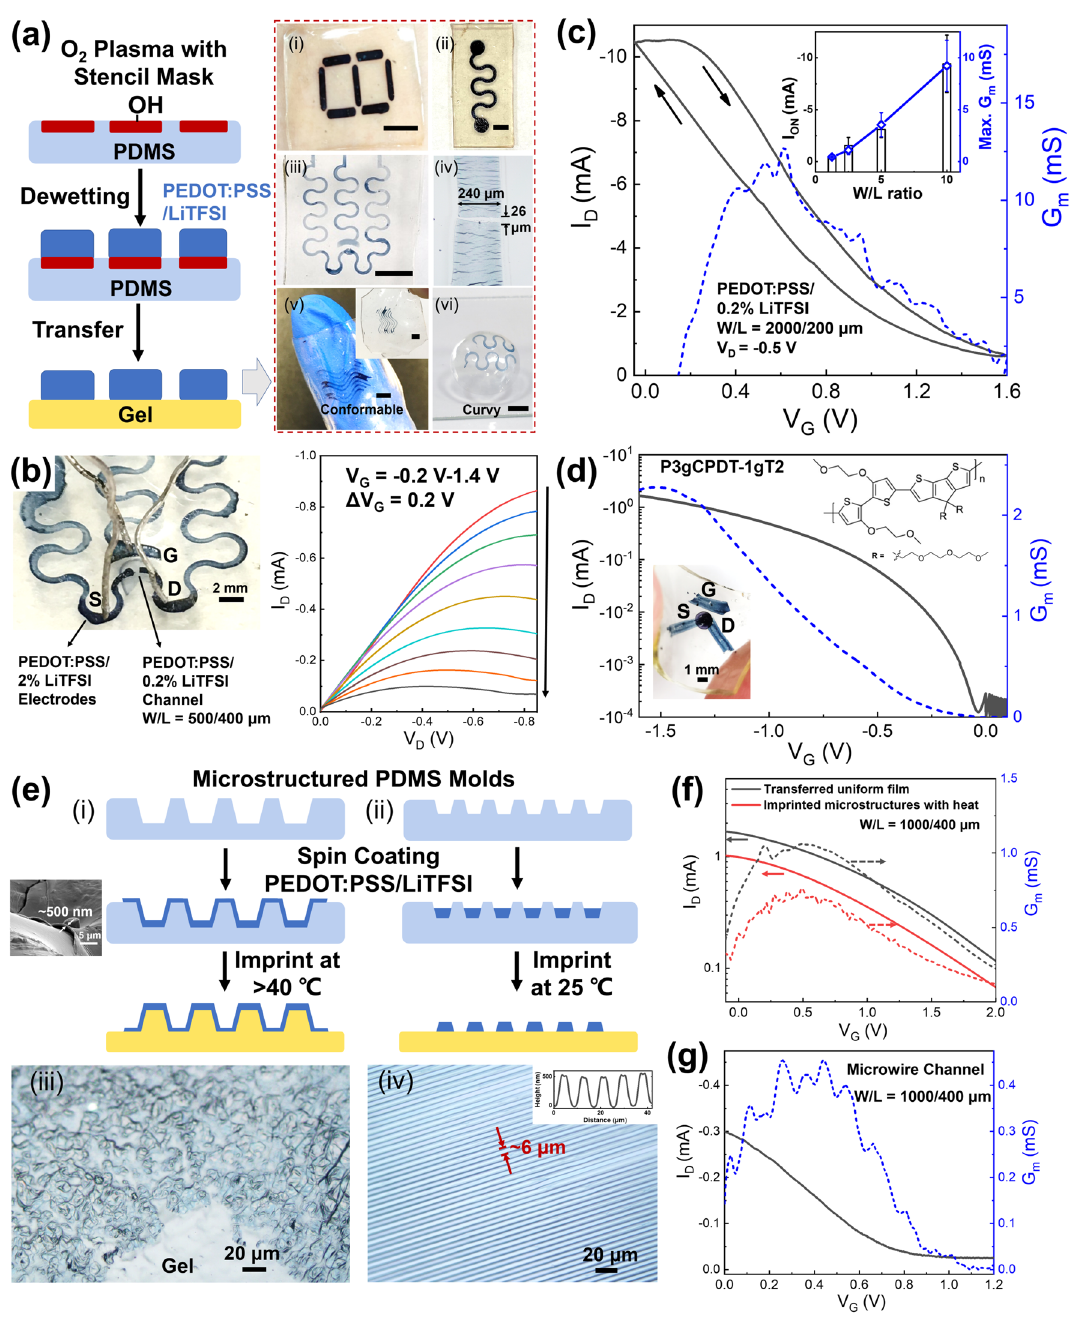
Fig. 3 a Schematic illustration of the patterning of PEDOT:PSS/LiTFSI by selective dewetting followed by transfer printing of these patterns onto GEL-GLY/ Na 3 Cit, including (i) “8”-shape pattern, (ii) serpentine pattern, (iii) stretchable serpentine arrays, (iv) ~ 240-μm-wide line with ~ 26 μm gap formed by cracking, (v) patterns on ultrathin gel film that was conformable to a finger, (vi) patterns printed on contact lens surface with an ultrathin gel coating. Scale bars in all photos are 5 mm. b Photo of a typical all-polymer OECT with W/L = 500/400 μm and its corresponding output characteristics, in which submicron-thick PEDOT:PSS/0.2% LiTFSI channel layer was printed on top of thick PEDOT:PSS/2% LiTFSI microelectrodes. c Typical transfer and G m curves of the all-polymer OECT with W/L = 2000/200 μm. Inset shows the plots of I G m with W/L ratio ( n = 4). d Transfer and G m curves of an enhancement-mode all-polymer ON and the maximum OECT using P3gCPDT-1gT2 as the channel. e Schemes (i, ii) and optical microscope images (iii, iv) of PEDOT:PSS/LiTFSI with 3D-microstructured (i, iii) and microwire (ii, iv) morphologies on the GEL-GLY/Na 3 Cit surface by imprinting using PDMS molds. The inserted scanning electron microscopy (SEM) image in (i) and cross-sectional atomic force microscopy (AFM) topography image in (iv) indicated the film thickness of ~ 500 nm in both microstructures. f Transfer and G m curves of OECTs based on imprinted 3D-microstructured and transferred uniform channel layers on the same gel electrolyte. g Typical OECT performance of the printed PEDOT:PSS/LiTFSI microwires on gel as the active